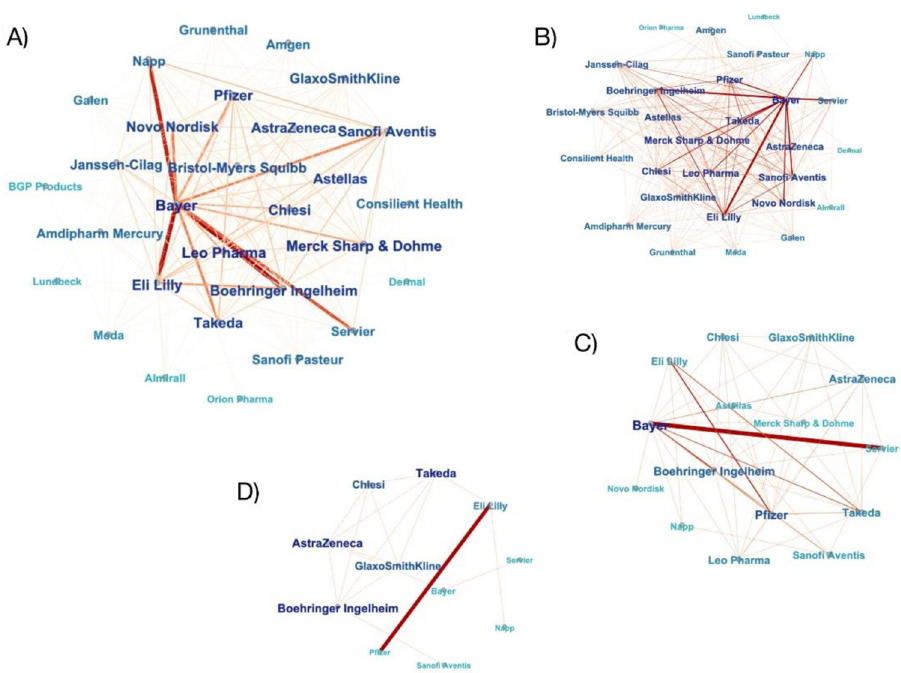
Fig 1. Networks based on the value of payments. Notes: 1A) network of all payments; 1B) network of payment over £100 per practice; 1C) network of payment over £1000 per practice; 1D) network of payment over £2500 per practice. Fig 1A–1D shows the visualisation of networks based on the value of payments, created in Gephi. Node label size and darkness corresponds to the centrality of a company, the strength and darkness of the lines corresponds to the number of shared practices between companies. The networks visibly change as the payment number to a single practice